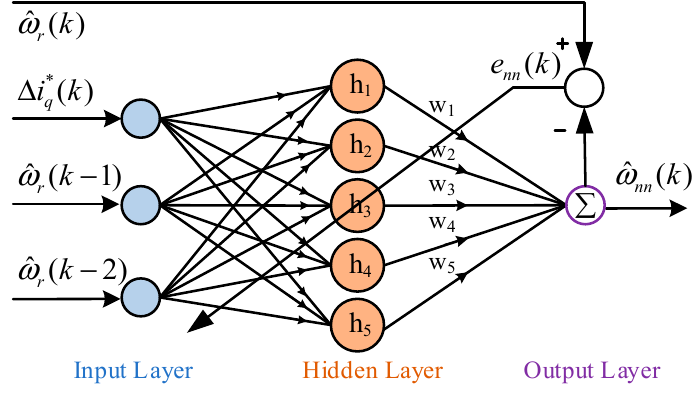
Figure 4. The RBFNN for tuning the PID parameters.